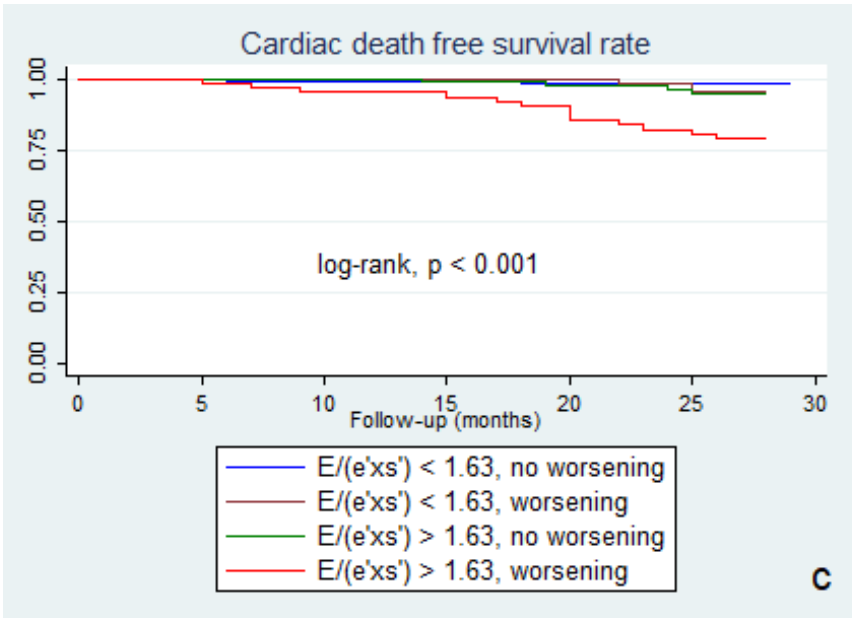
Figure 2. Kaplan–Meier survival curves of composite outcome ( a ), hospital re-admission ( b ) and cardiac death ( c ) according to the initial E/(e’×s’) value below and above 1.63, and to E/(e’×s’) worsening six weeks after hospital discharge. E = peak early diastolic transmitral velocity; e’ = peak early mitral annular diastolic velocity; s’ = peak systolic mitral annular.